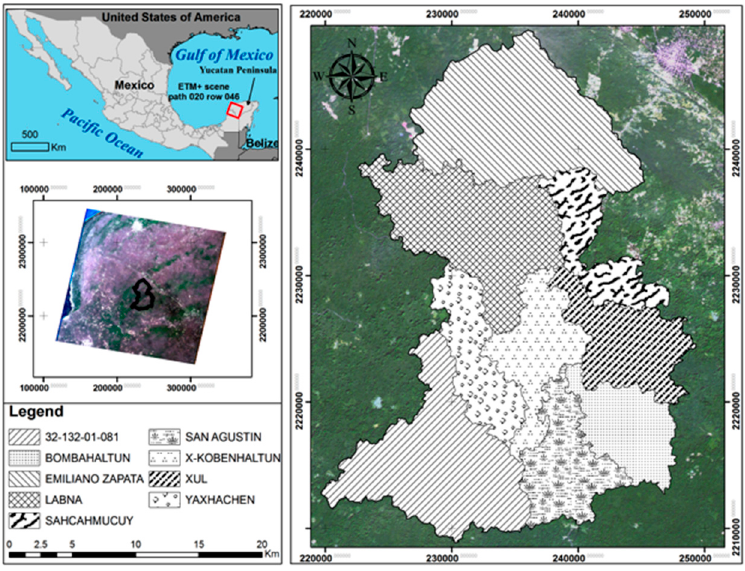
Figure 1. Study area “Menda 1” in the geographical context of the Yucatan Peninsula, Mexico.